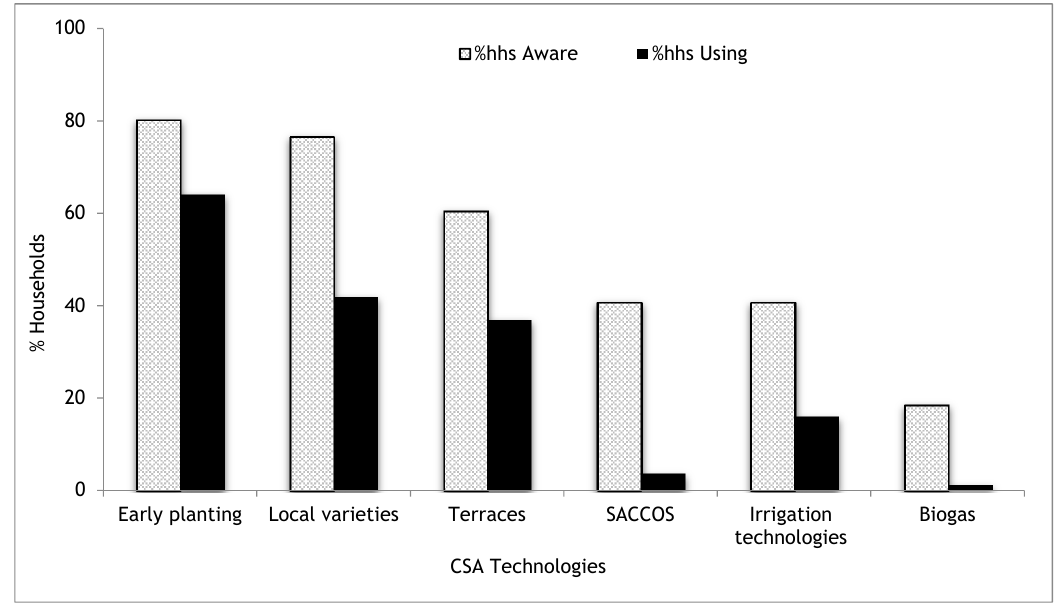
Figure 4. CSA practices with the largest discrepancies between awareness and use of practice in Lushoto.